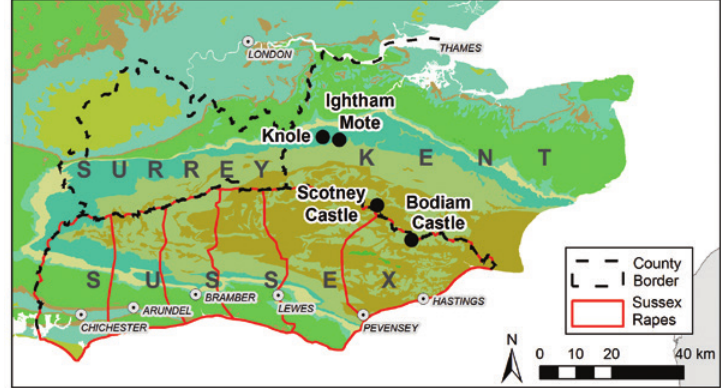
Figure 12.5; drawing by Kathryn A.